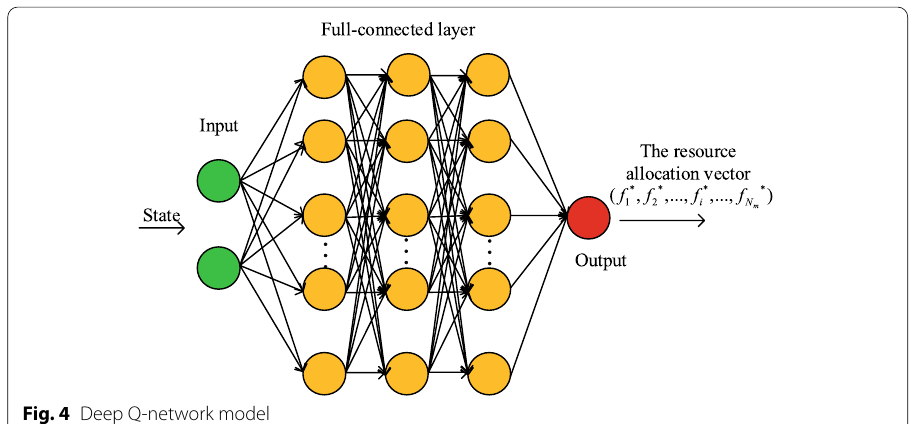
Fig. 4 Deep Q-network